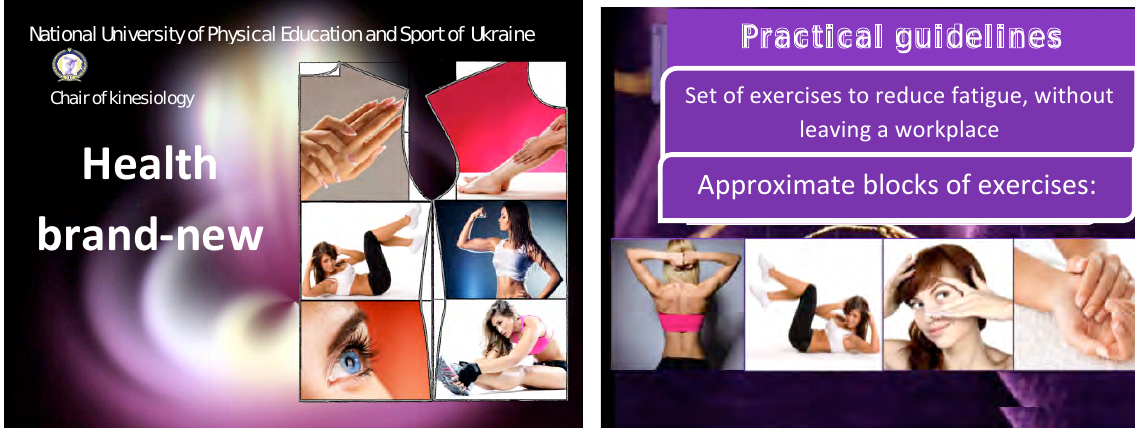
Fig. 2. Working windows of informationally-methodical system “Health brand-new”